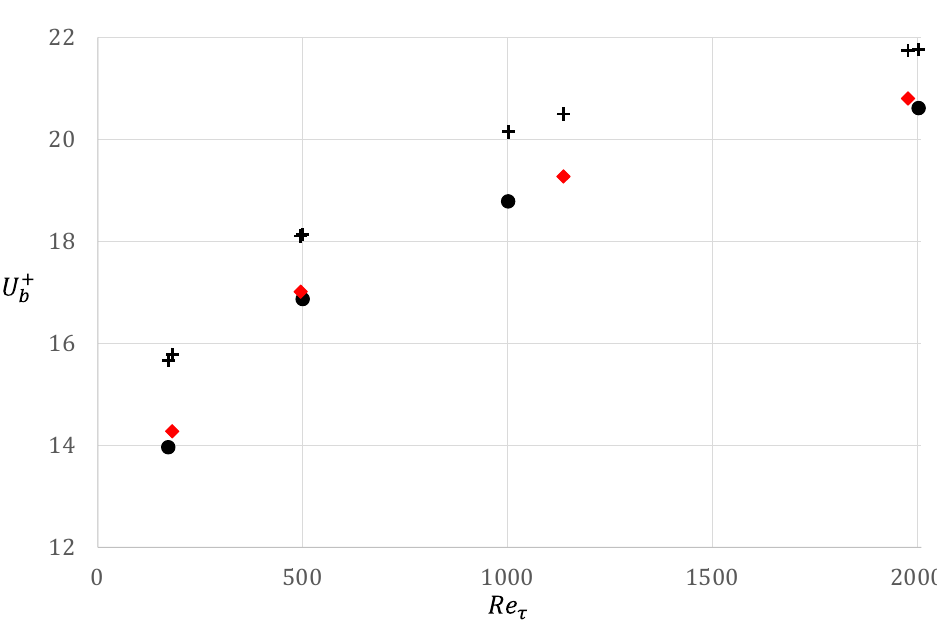
Figure 9. Trend of the mean velocity U b + ; • pipe DNS data [26]; (cid:7) pipe DNS data [31,32]; and + channel ITM.